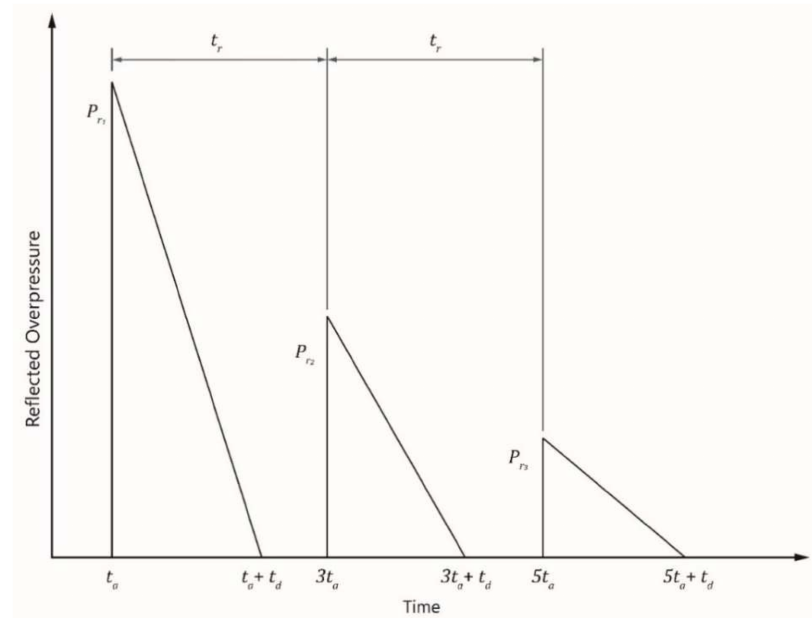
Figure 2. Simplification of the internal blast wave reflections adapted from [13].